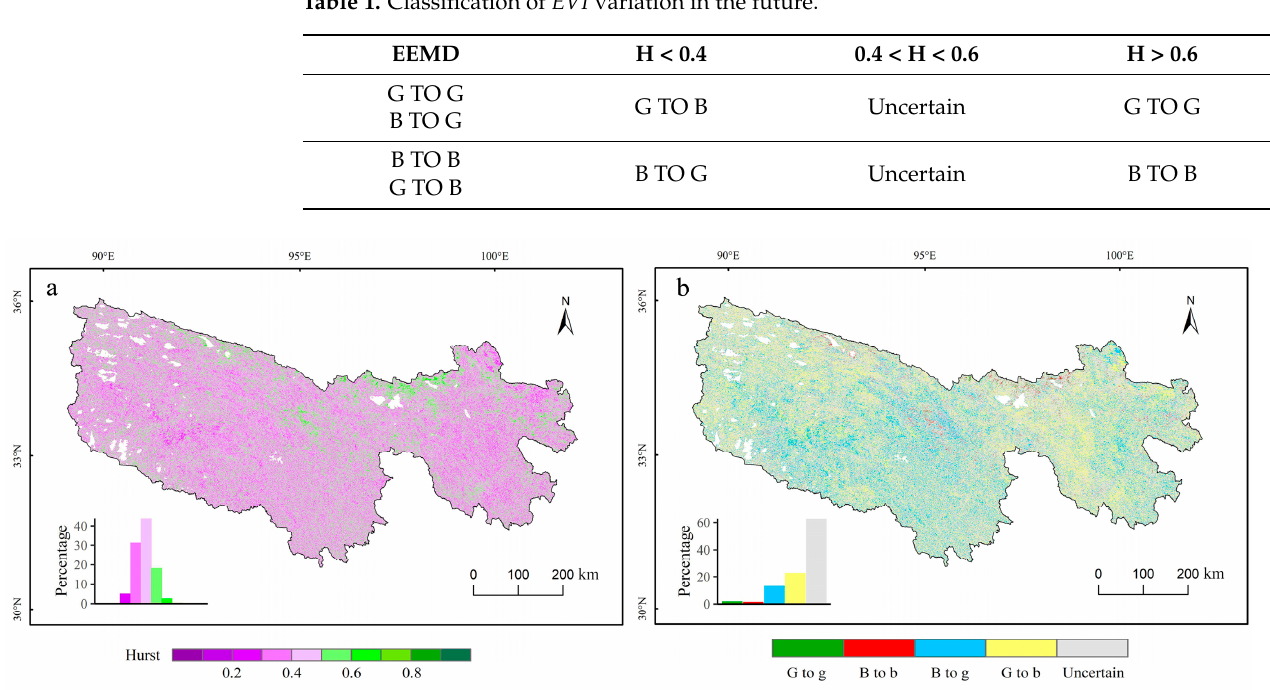
Table 1. Classification of EVI variation in the future.